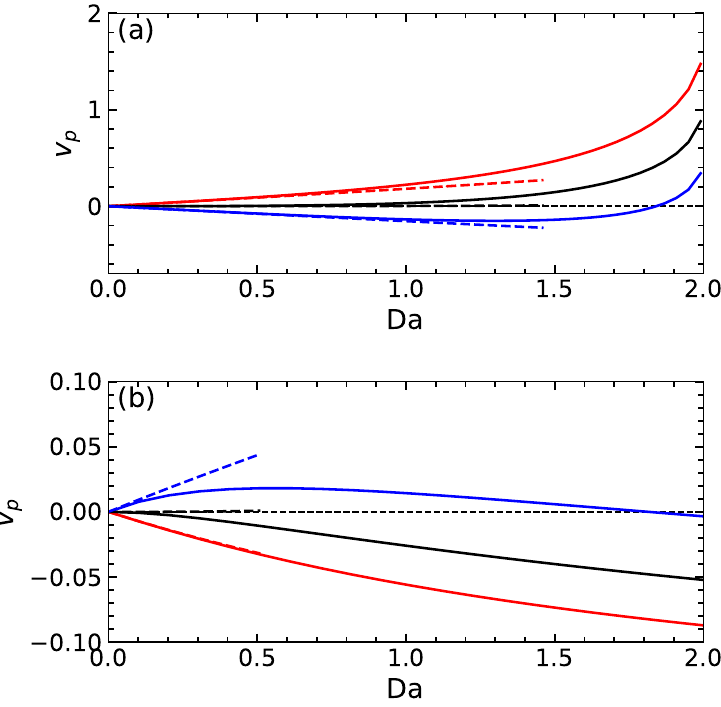
Figure 4. A propulsion velocity of swimmers of the first type ( a ) calculated using φ s = 0.5, 0, and − 0.5 (solid curves from top to bottom) and second type ( b ) computed with the same surface potentials (solid curves from bottom to top). Dashed lines correspond to calculations within the linear